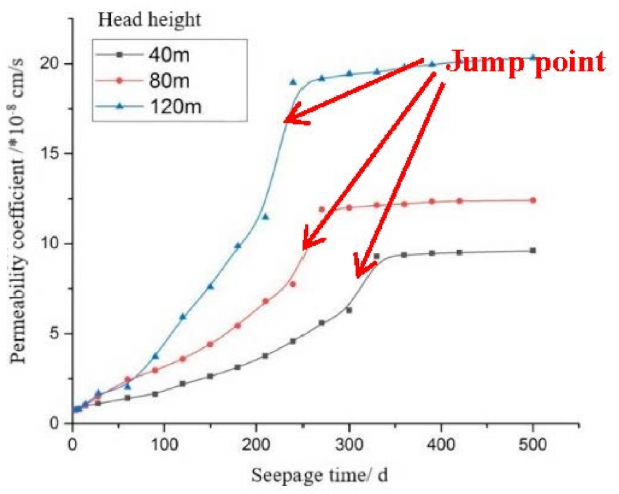
Figure 6. The seepage coefficient of grouting-reinforced body changes with time under seepage